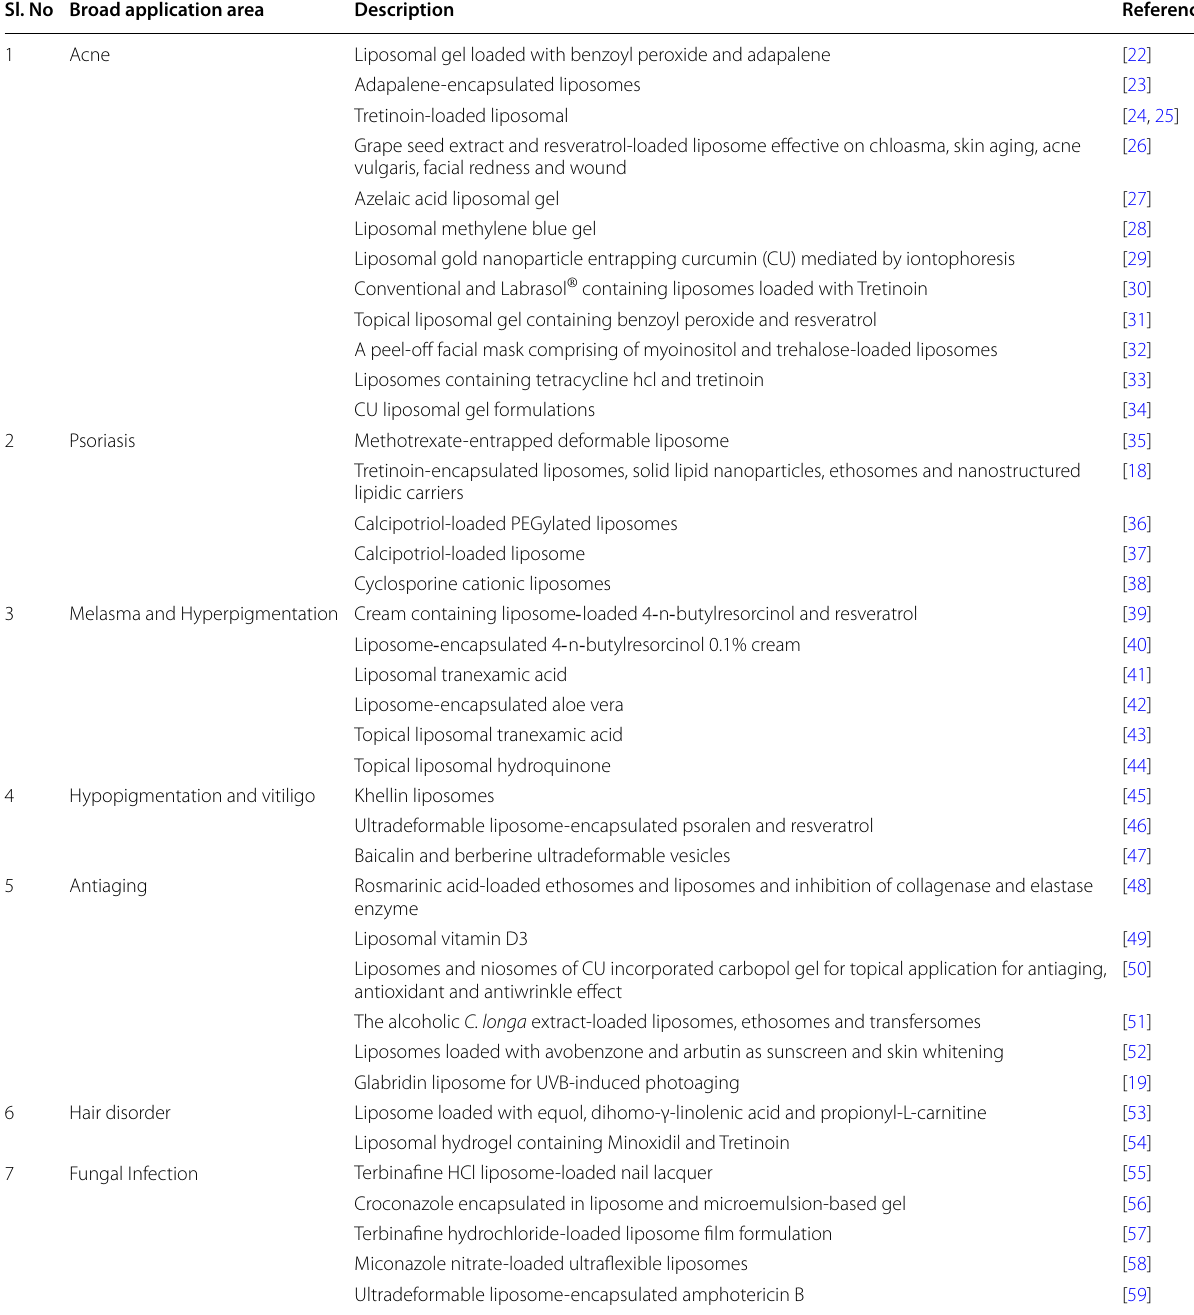
Table 1 Cosmeceutical applications of liposome and description with the therapeutic molecule Sl. No Broad application